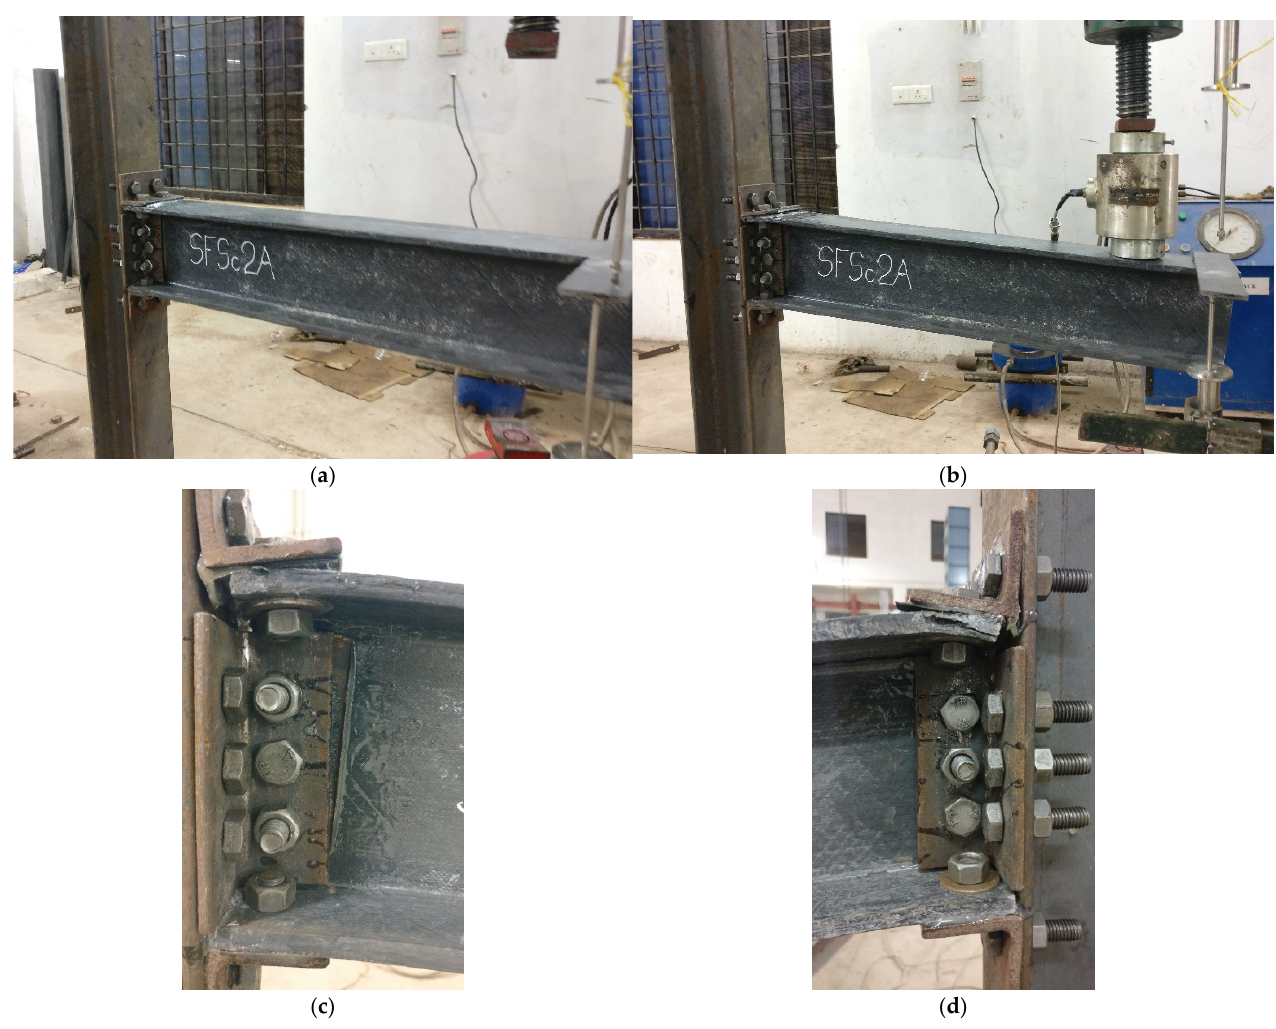
Figure 12. Adhesive debonding and shear-out failure in specimen SFSc2A: ( a ) Undeformed joint; ( b ) Deformed joint; ( c ) Deformed close-up front view; ( d ) Deformed close- up back view.